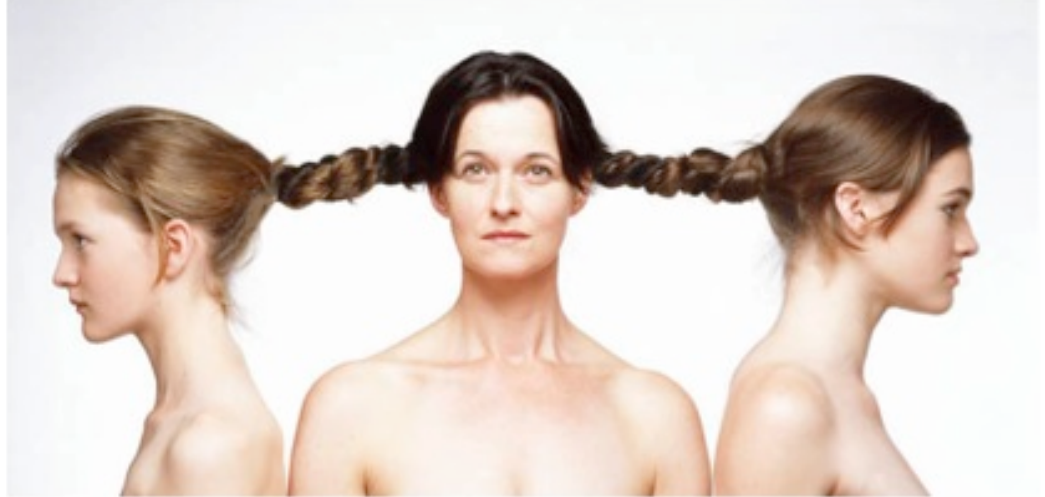
Heather Hanna, A Visual Essay: Interventions and Manipulations in the Maternal Studies in the Maternal, 4(1), 2012,